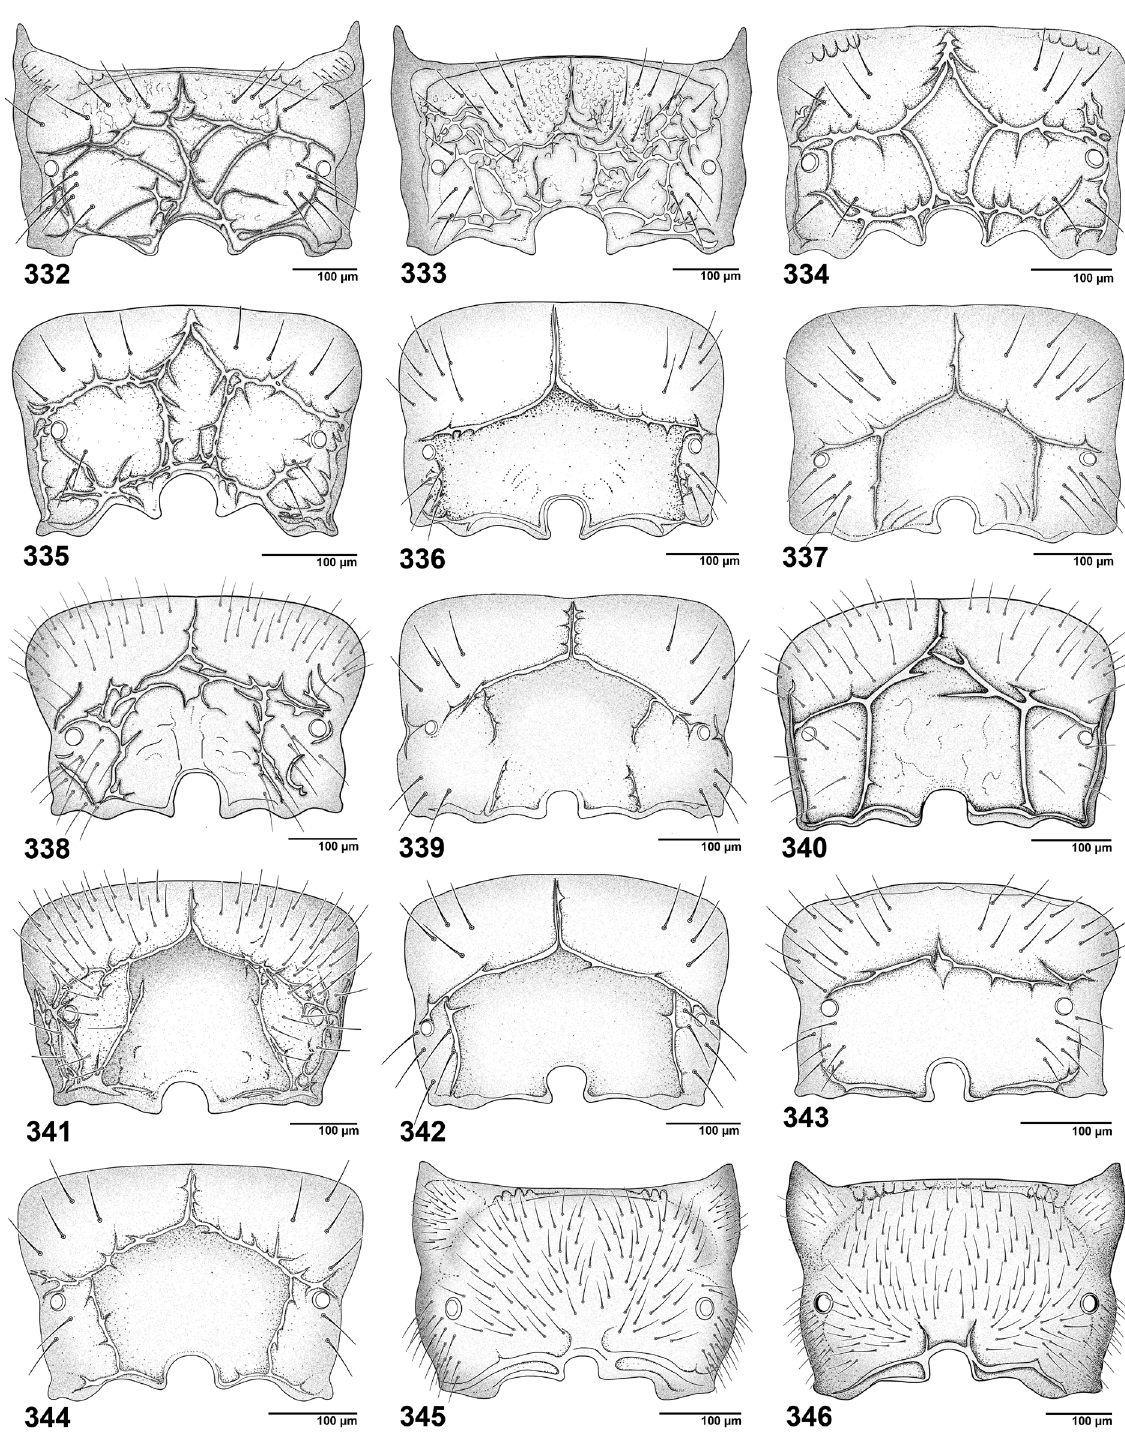
Figs 332–346. Dorsal aspect of propodeum (♀): 332 . Monoctonia pistaciaecola . 333 . Monoctonia vesicarii . 334 . Monoctonus crepidis . 335 . Monoctonus mali . 336 . Pauesia abietis . 337 . Pauesia anatolica . 338 . Pauesia antennata . 339 . Pauesia cedrobii . 340 . Pauesia hazratbalensis . 341 . Pauesia picta . 342 . Pauesia pini . 343 . Pauesia silana . 344 . Pauesia unilachni . 345 . Praon abjectum . 346 . Praon absinthii